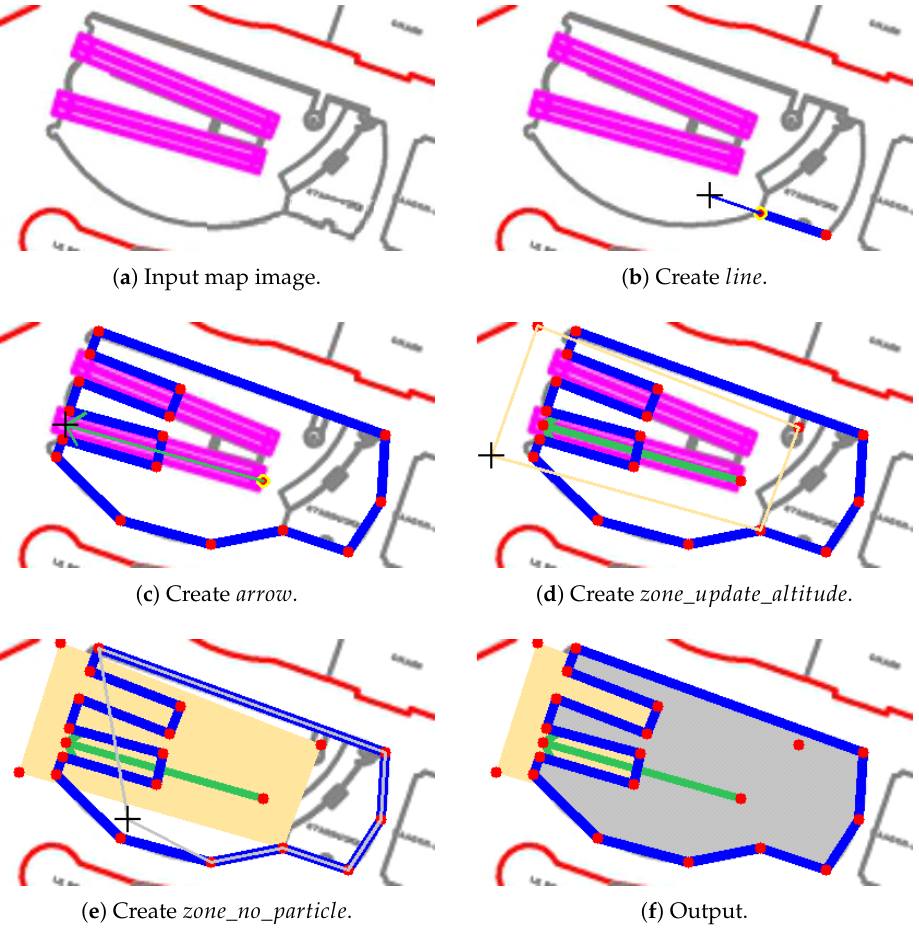
Figure 11. Map-editing